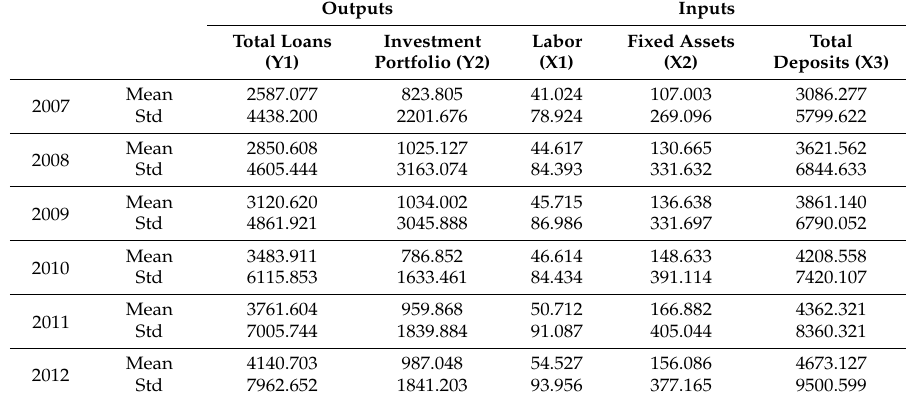
Table 1. Descriptive statistics of outputs and inputs (in US$